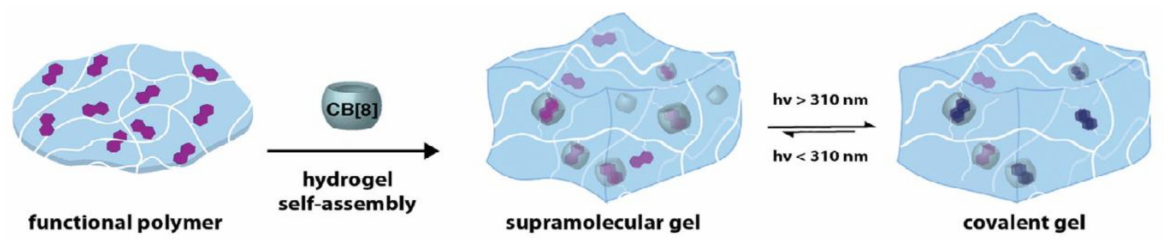
Figure 47. The concept for photo-switchable coumarin-functionalized biopolymers. Republished with permission of the Royal Society of Chemistry, from [237]; permission conveyed through Copyright Clearance Center,